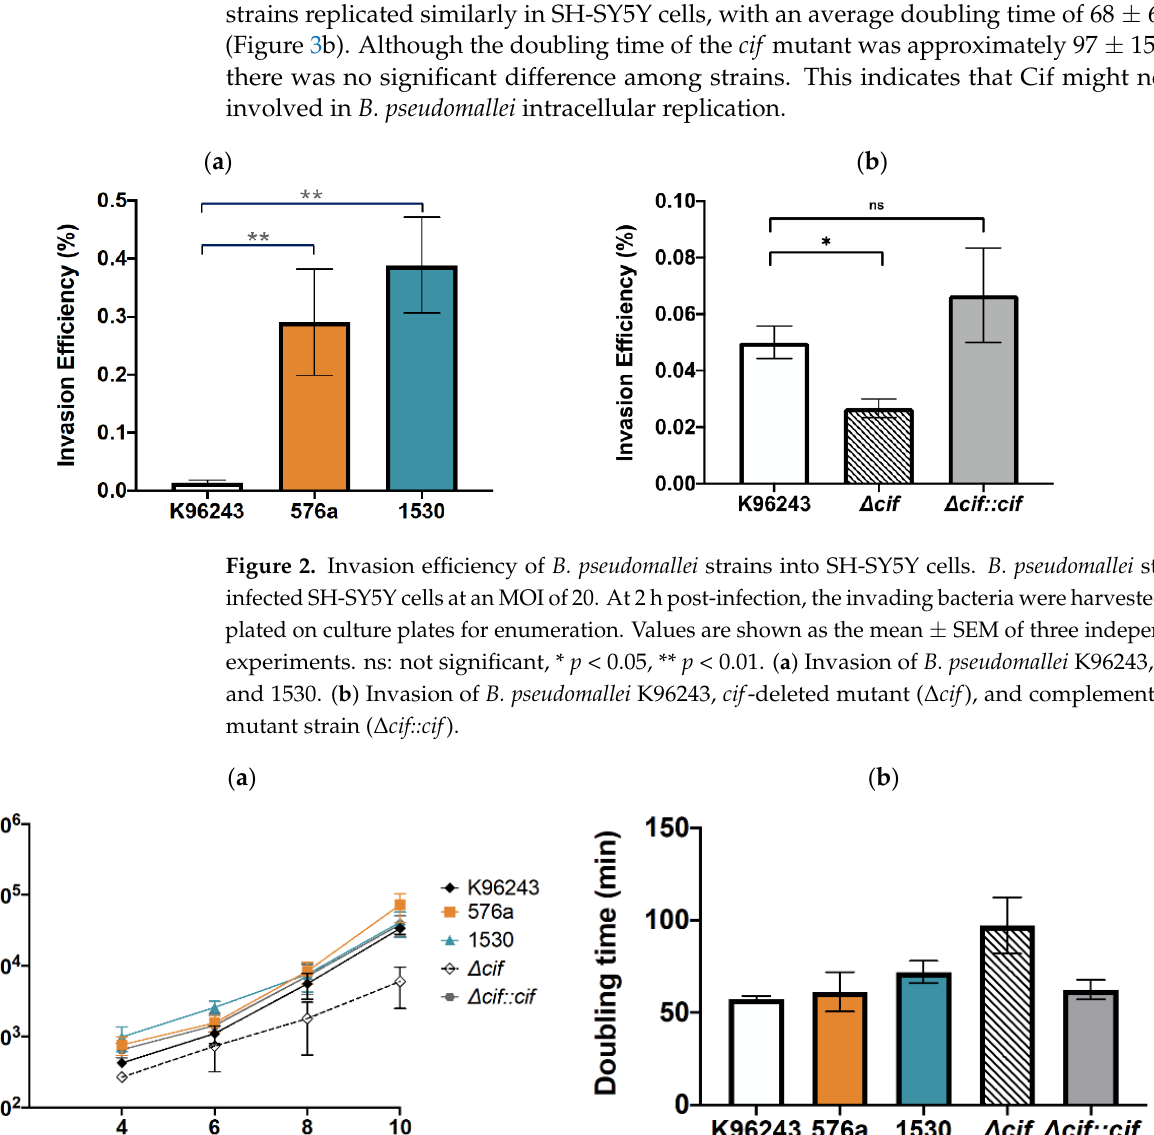
Figure 3. Intracellular survival and replication rate of B. pseudomallei strains in SH-SY5Y cells. ( a ) Intracellular replication and ( b ) doubling time were determined for each tested bacterial strain. Data are the mean ± SEM.